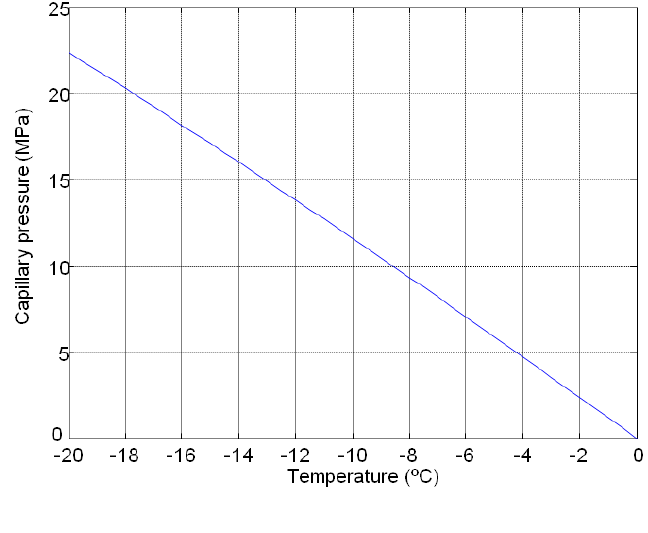
Figure 2. Numerical study of the theoretical behaviour of the capillary pressure versus